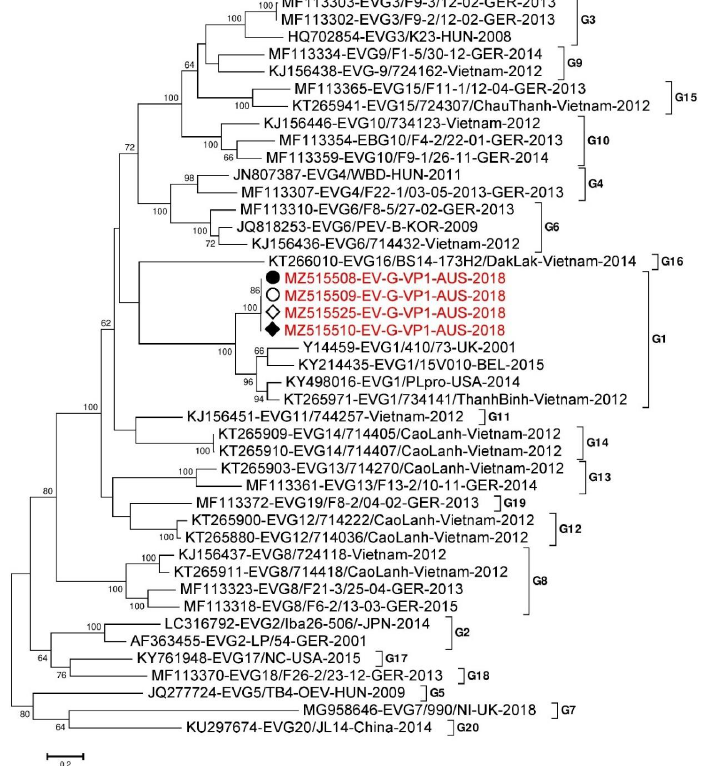
Figure 2. Phylogenetic analysis of complete nucleotide sequence of VP1 capsid region of EV-G. The nucleotide sequences were aligned and analysed using the maximum likelihood method in MEGA 7.0 [63] using the General Time Reversible (GTR + G) [70] model with a bootstrapping of 1000 replicates. The analysis involved 39 reference sequences of the VP1 capsid region of EV-Gs genome and four EV-G sequences from this study. The numbers at nodes represent bootstrap values and values above 60% are shown. Branch lengths are scaled according to the numbers of nucleotide substitutions per site. Sequences name indicated in red colour from Pig 45 colon and lung sample have been labelled with a black ( ⬤ ) and white circle ( ⭘ ), respectively while Pig 46 colon and lung sample have been labelled with a black ( ♦ ) and white rhombus ( ◊ ), respectively.